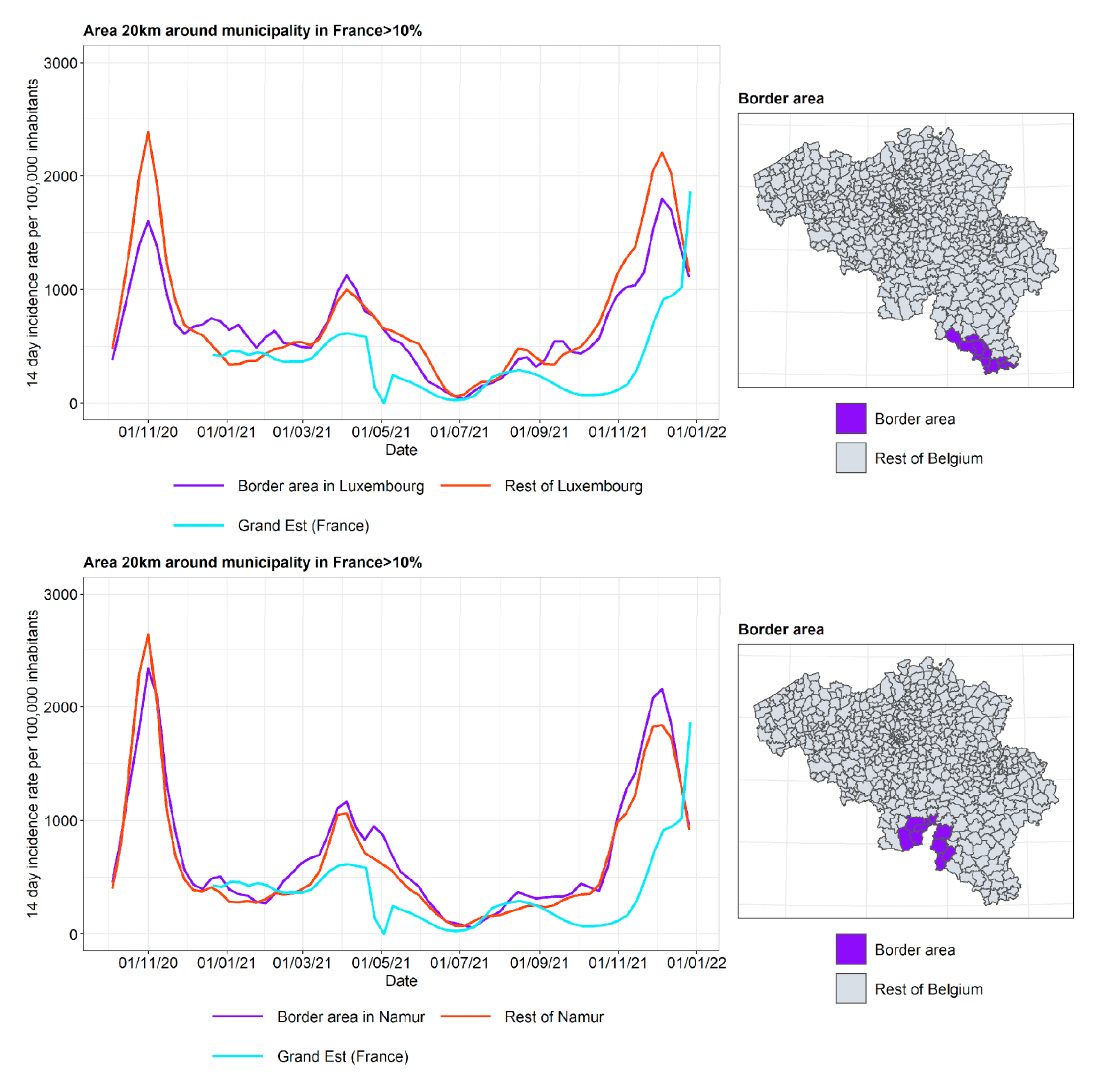
Figure 11. COVID-19 incidence curves for the border area with Grand Est (France).